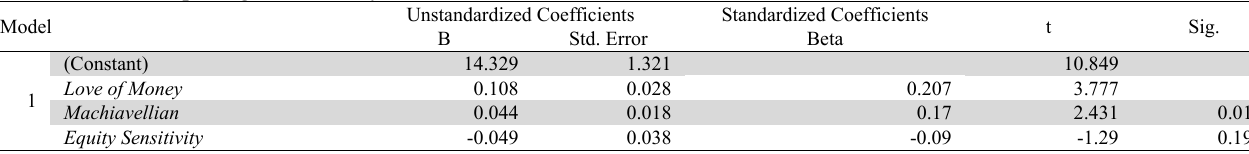
The results of multiple regression analysis Model